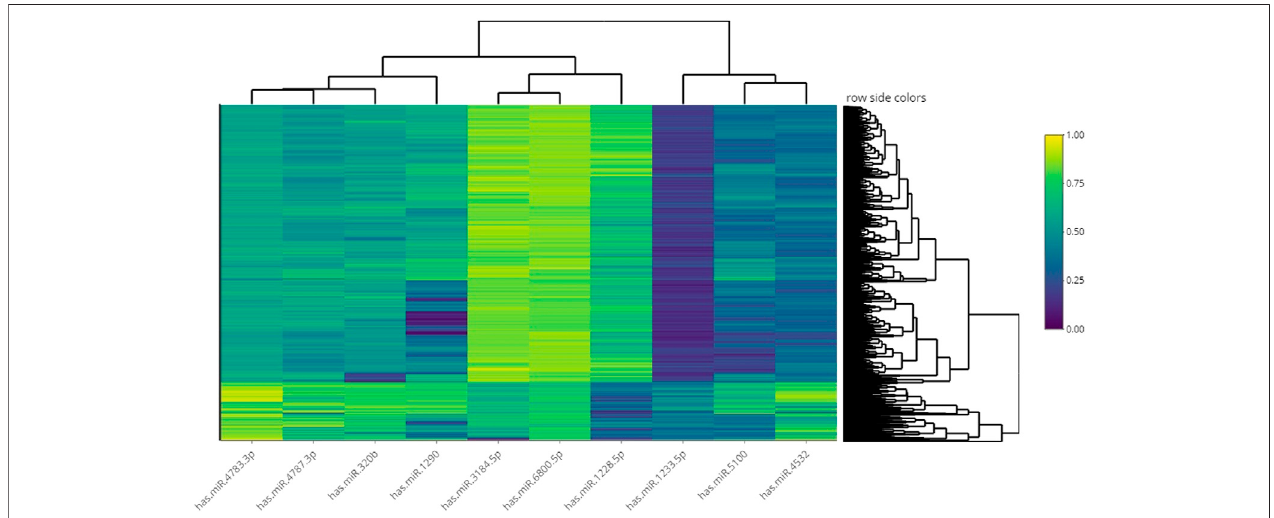
FIGURE 3 | Heatmap of hierarchical clustering analysis using the 10 identi fi ed miRNAs to distinguish different samples in the dataset GSE106817.